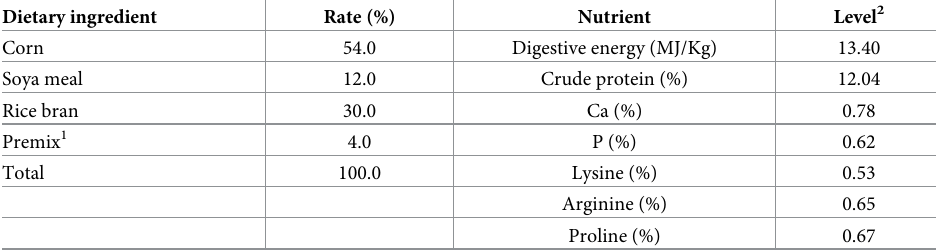
Table 1. Ingredient and nutrient levels of the basal diet (air-dry basis). Dietary